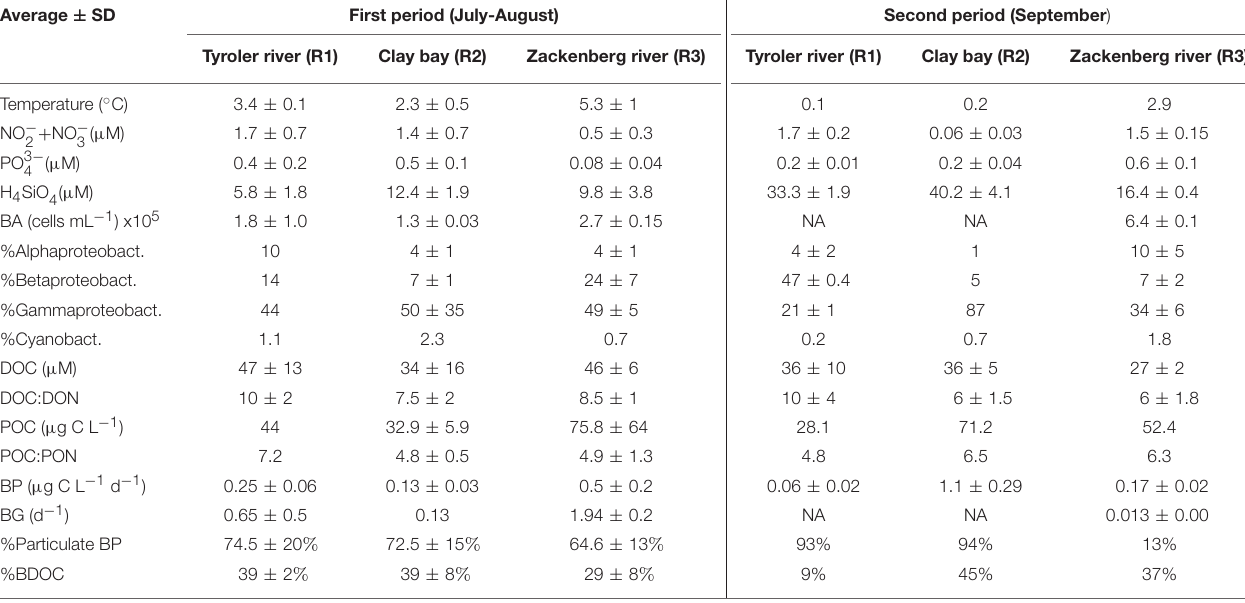
TABLE 2 | River properties presented as average ± SD ( n varies from 3 to 6) for each of the two time periods.